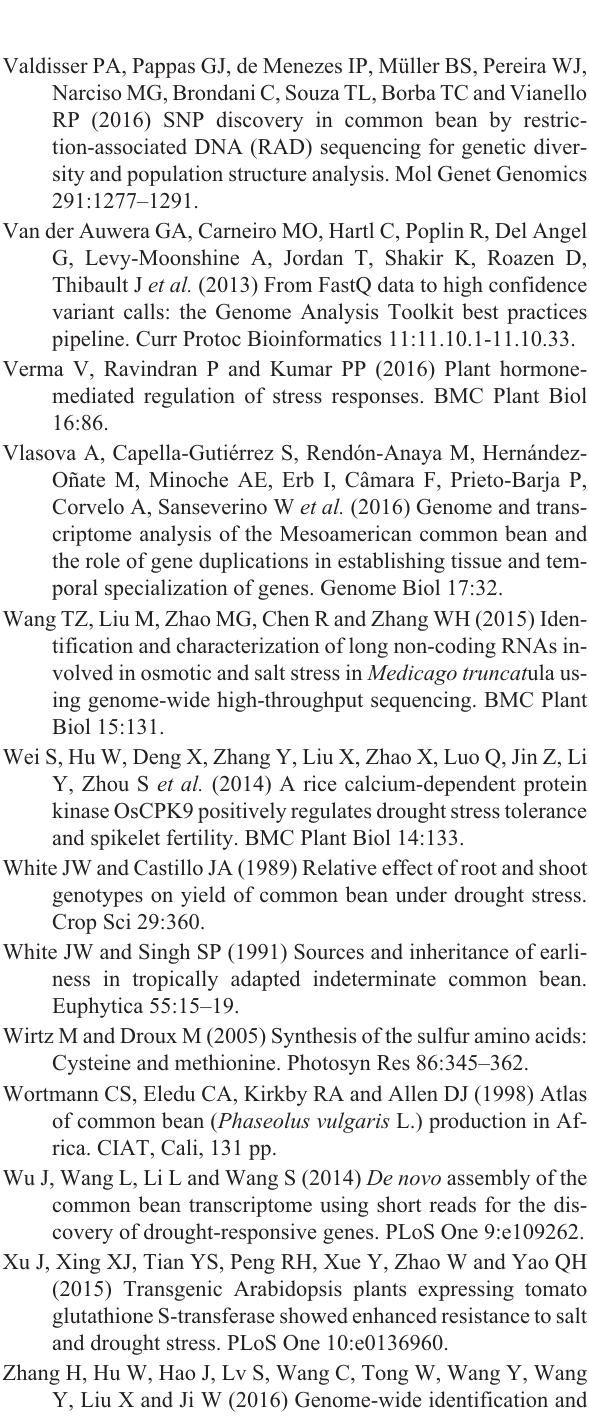
Table S4 - Statistical assessment of GO term enrichment. Table S5 - KEGG metabolic pathways identified for the new loci and DEGs. Table S6 - Description of the 397 loci with no hit in Blastx or PSI-Blast). Table S7 - Expression values of the differential expressed genes. Table S8 - Number of variants identified after each Base Quality Score Recalibration (BQSR)